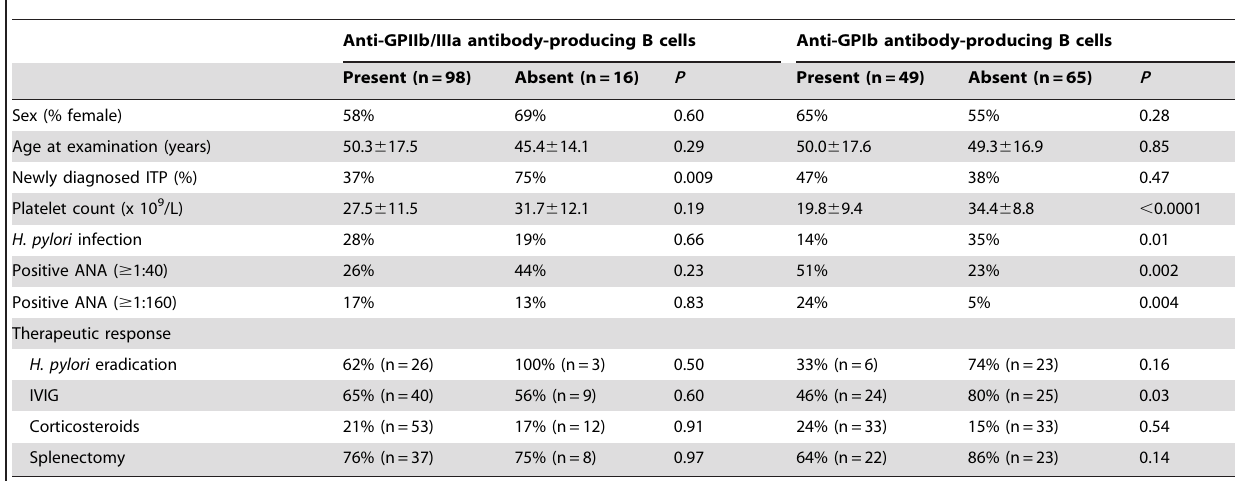
Table 3. Clinical findings in patients with primary ITP, stratified by the presence or absence of circulating anti-GPIb or anti-GPIIb/ IIIa antibody-producing B